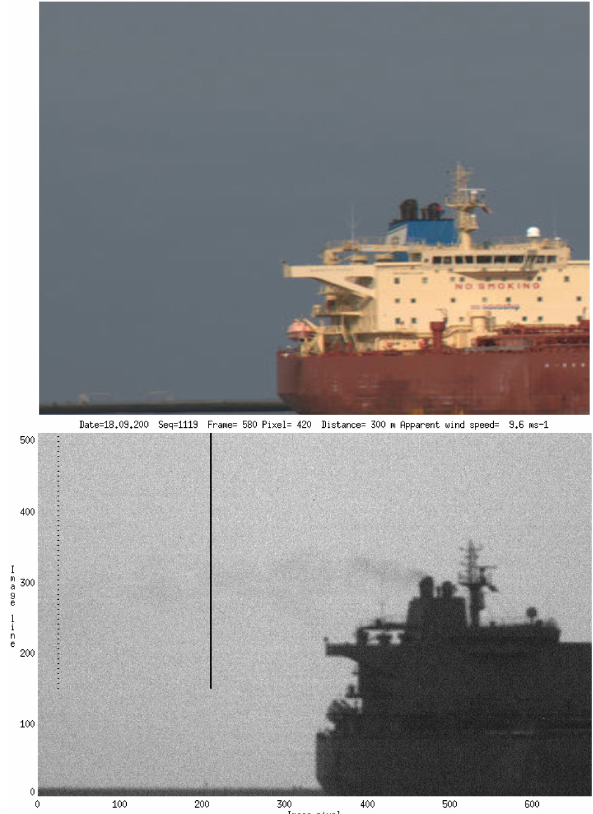
Fig. 12. Top: visible image of NS Concept (IMO 9299692) under steam into Hoek van Holland. Bottom: UV image of the same ship. The black line shows the location of the vertical transect through the plume; the dashed line shows the location of the reference vertical